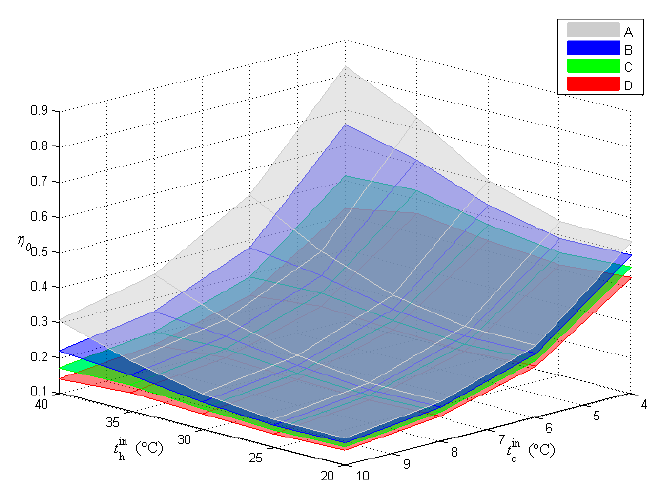
Figure 8. Relationship of η 0 = f ( 𝑝 (cid:3030)(cid:3042)(cid:3048)(cid:3047) ,𝑡 (cid:3035)(cid:3036)(cid:3041) , 𝑡 (cid:3030)(cid:3036)(cid:3041) ).